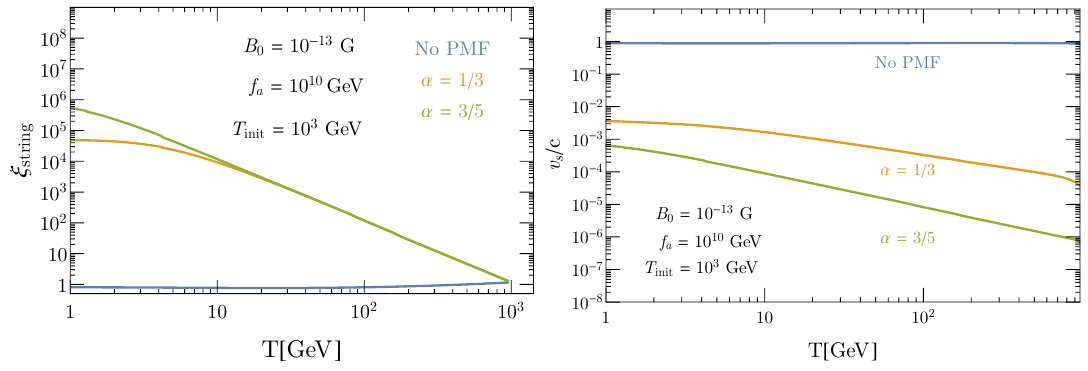
Figure 3 . Evolution of current carrying axion strings vs. temperature. Left : number of strings per Hubble volume ξ . Right : average string velocity v . The velocity drops immediately when the string s current is turned on, and then starts growing again due to string